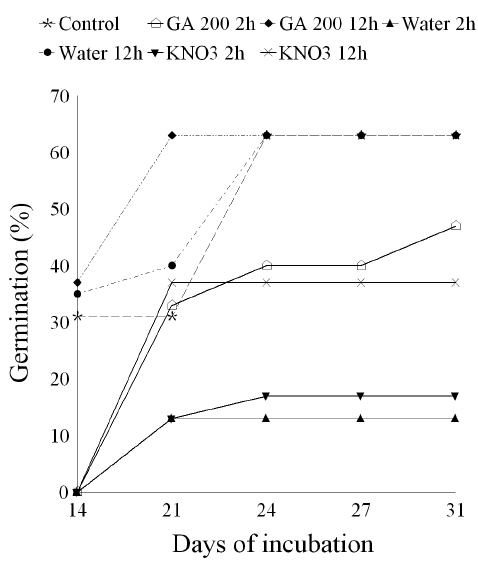
Fig. 1- Percentage of Croton urucurana Baill, seeds germinated in each pre-germinative treatment (water and GA – gibberellic acid) and incubated at 20/30°C during the